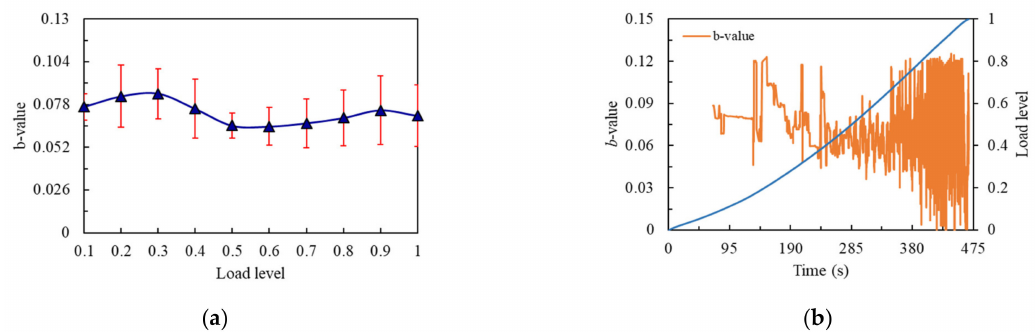
Figure 10. b -value curves of the No.14 notched beam: ( a ) b -value changes curve with load level; ( b ) b -value changes curve with